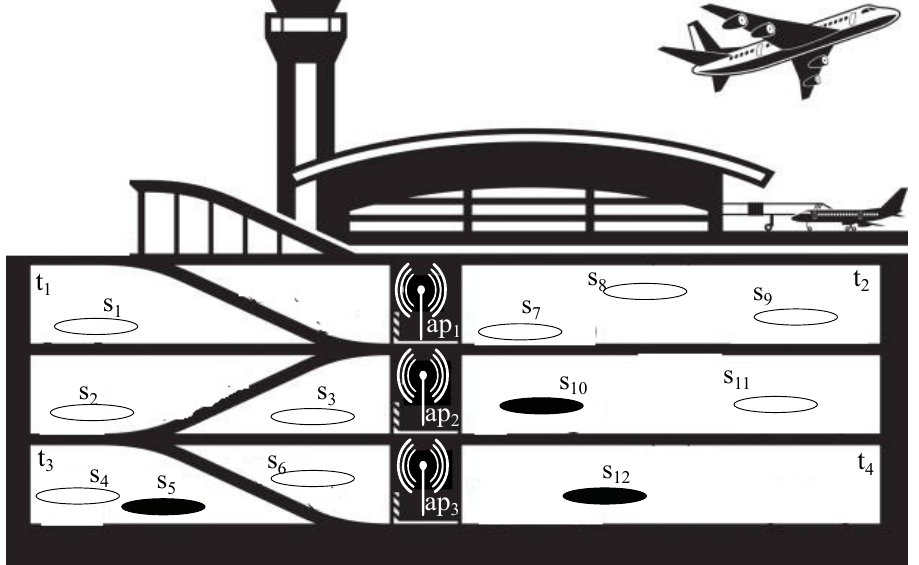
Figure 2. A running